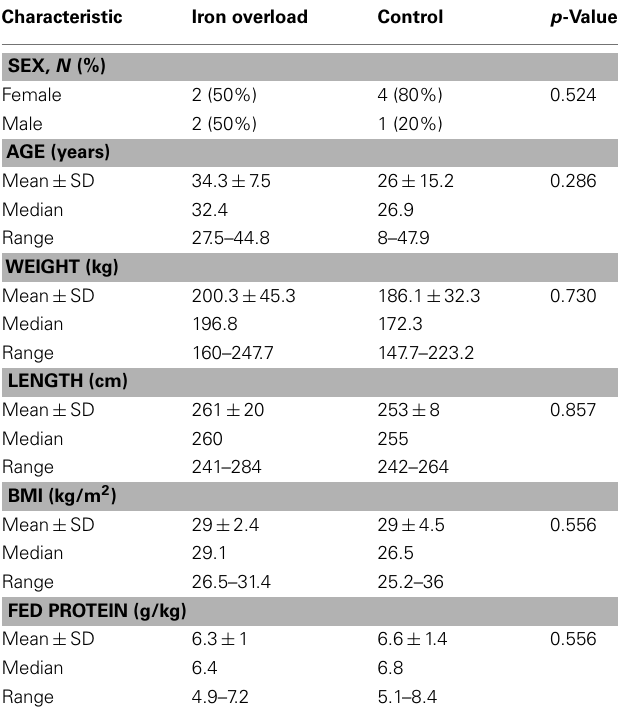
Table 2 | Study group characteristics